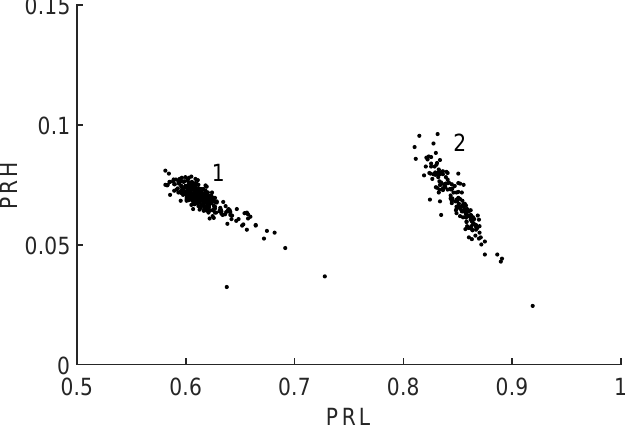
Figure 6. 2D map with the clusters of the signals from two sections of the cable emitting partial discharges in the radio-frequency